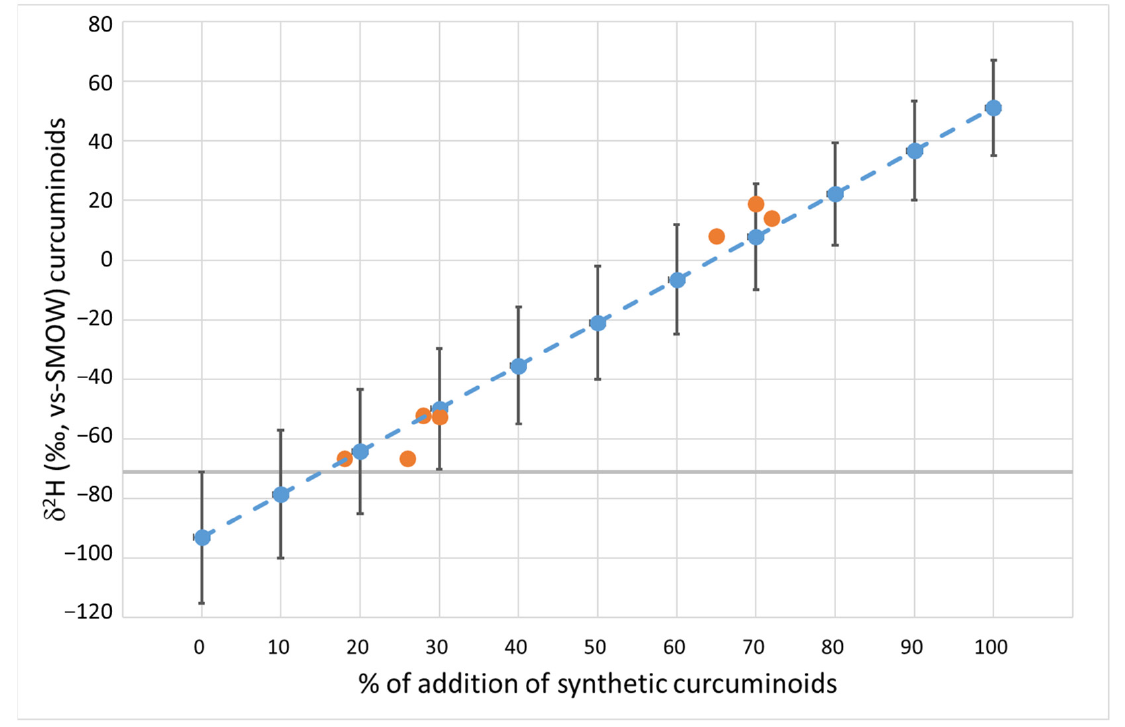
Figure 2. Variations in the δ 2 H values of natural curcuminoids with the addition of synthetic